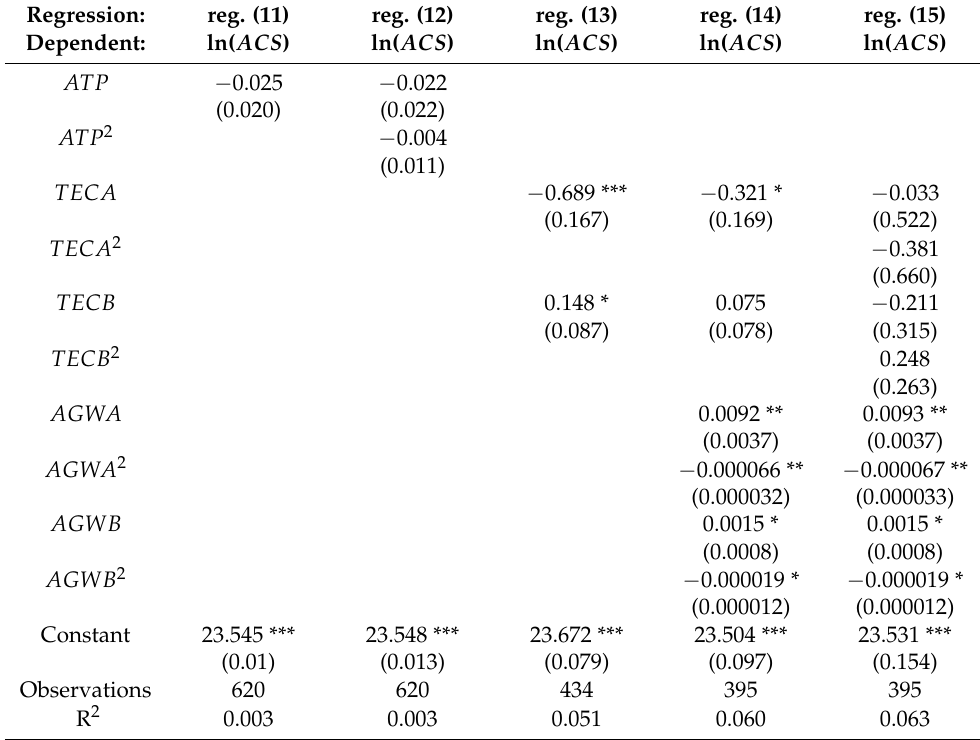
Table 6. Effects of agricultural technology progress on